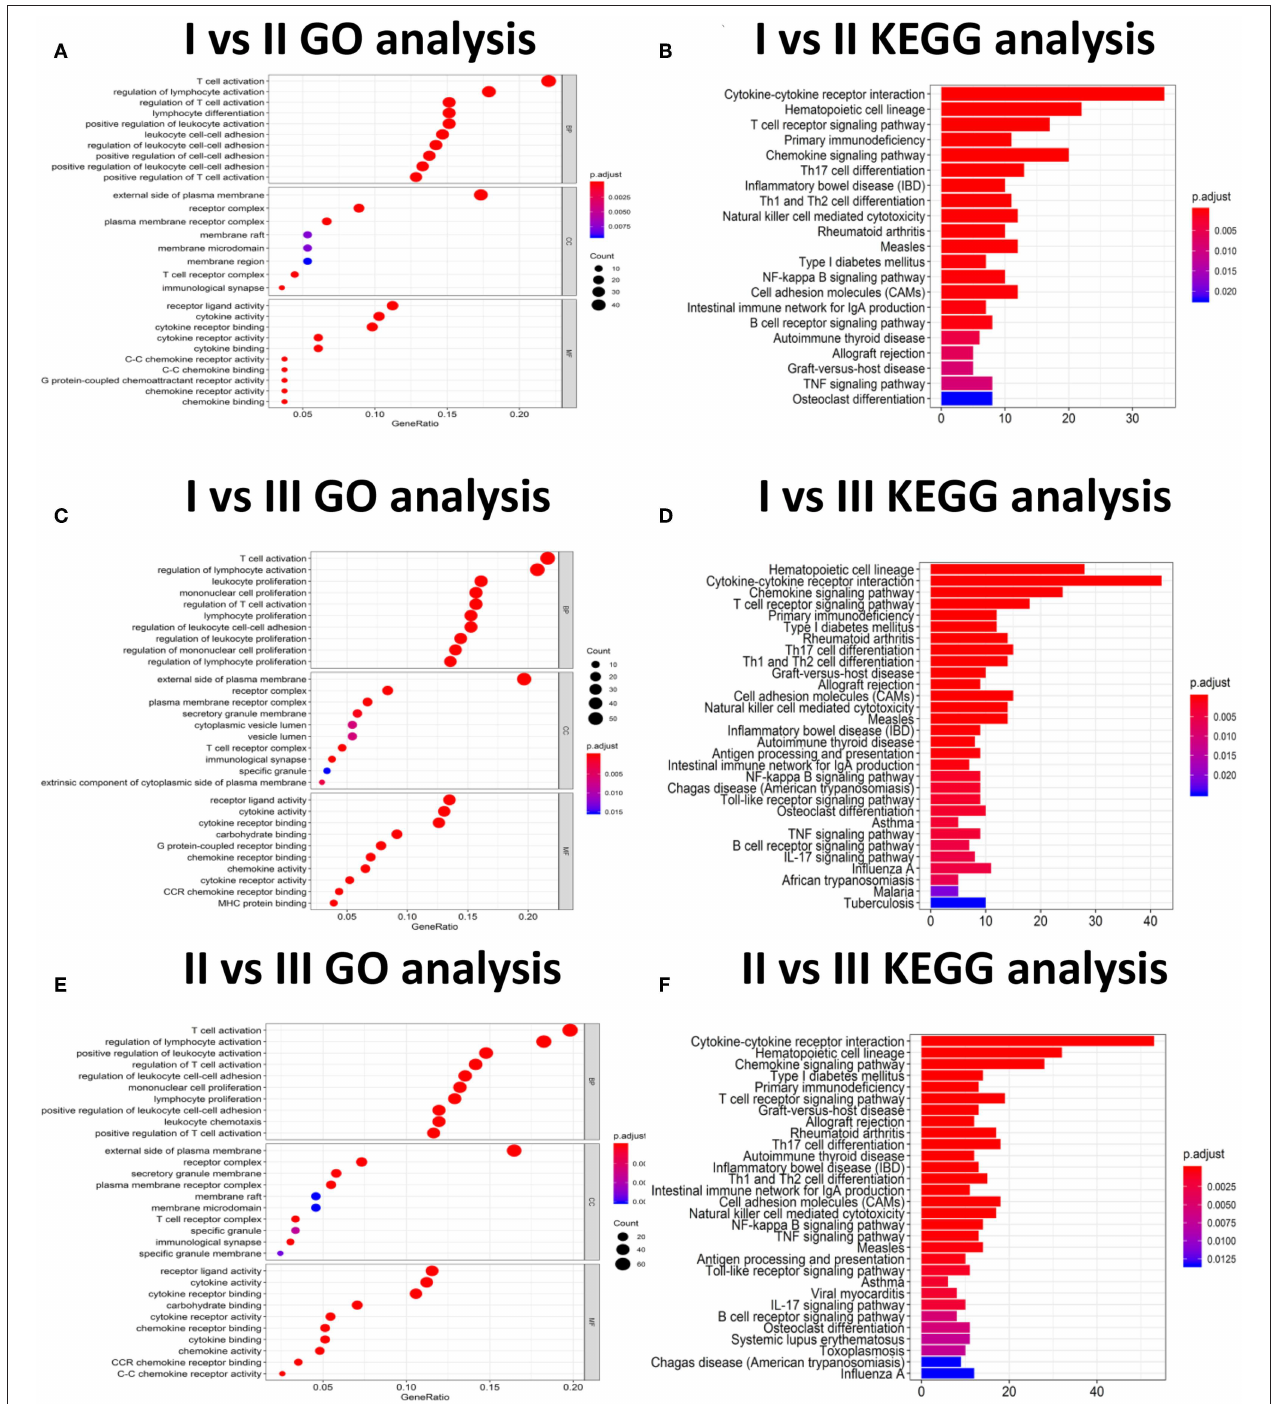
FIGURE 15 | The GO and KEGG analysis for three HNC clusters. (A–F) Is for cluster I vs. Cluster II, cluster I vs. cluster III and cluster II vs. Cluster III.